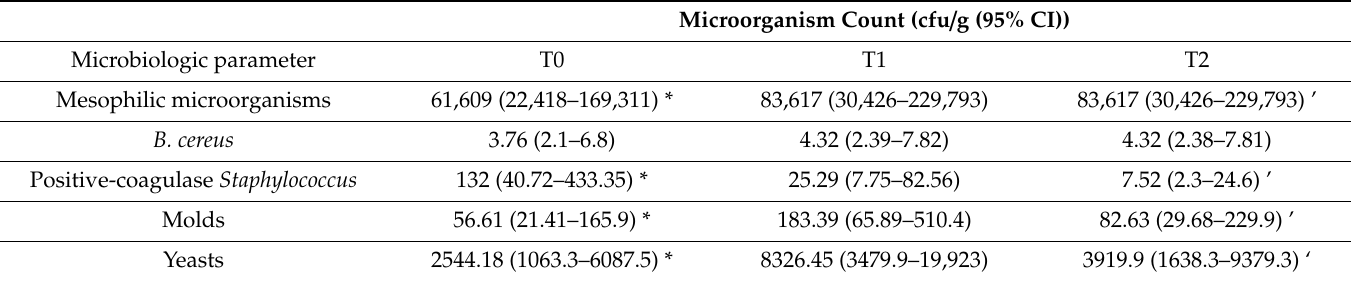
Table 1. Microorganism counts in analyzed samples, reported as mean and 95% confidence interval and relative di ff